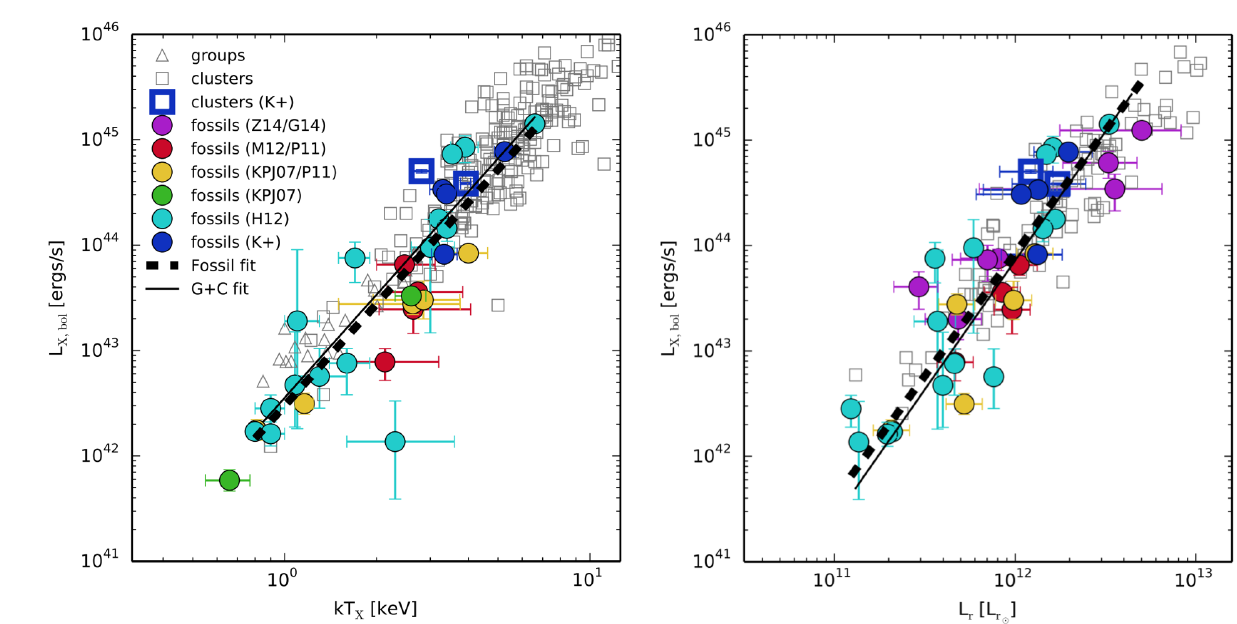
Figure 4. Left panel : The X-ray temperature versus the bolometric X-ray luminosity as presented in Kundert et al. [50]. Grey triangles and squares are groups and clusters, respectively. Systems labeled with K+ are taken from Kundert et al. [50], Z14 from Zarattini et al. [22], G14 from Girardi et al. [49], M12 from Miller et al. [51], P11 from Proctor et al. [52], KPJ from Khosroshahi et al. [47], and H12 from Harrison et al. [14]. The plotted lines are the orthogonal BCES fits to the fossil sample (dashed line) and to the sample of groups and clusters (solid line) computed in the same range of parameters. Right panel : the total r − band luminosity versus the bolometric X-ray luminosity as presented in Kundert et al. [50], with the same lines of colour code as in the left panel, see the Figure 5 of [50] for